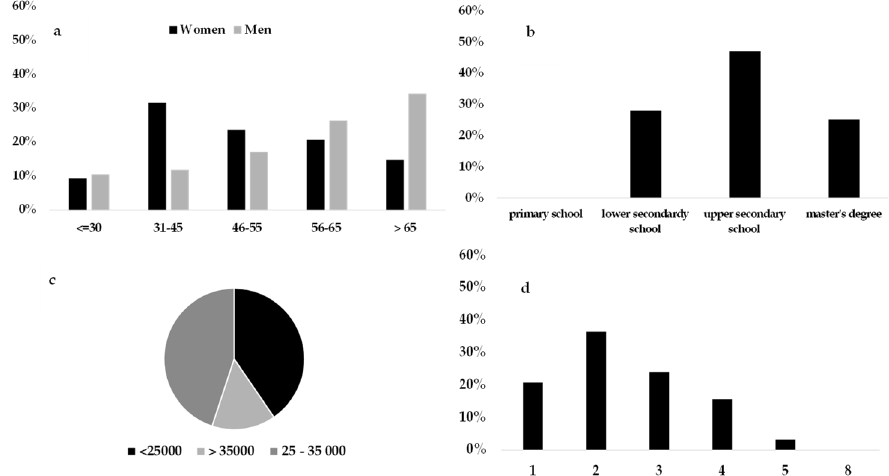
Figure 2. Sociodemographic characteristics of consumers belonging to the local sensitive cluster: ( a ) Gender and age groups proportion, ( b ) educational level, ( c ) yearly average income bracket, and ( d ) number of family components.